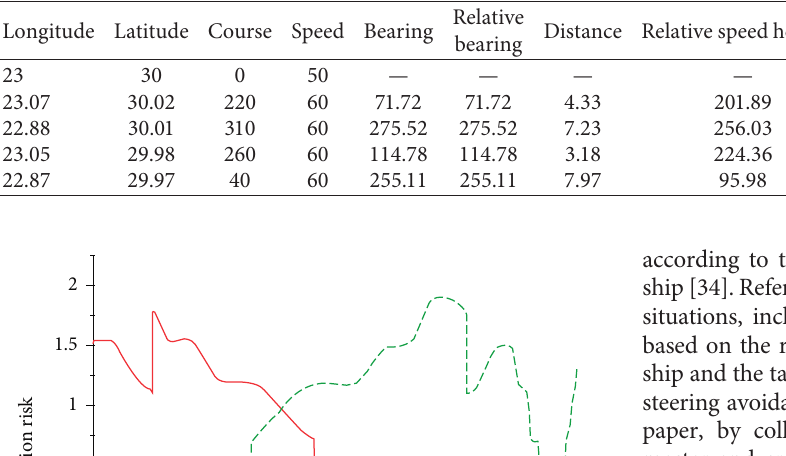
Table 2: Related data of own ship and other ships.